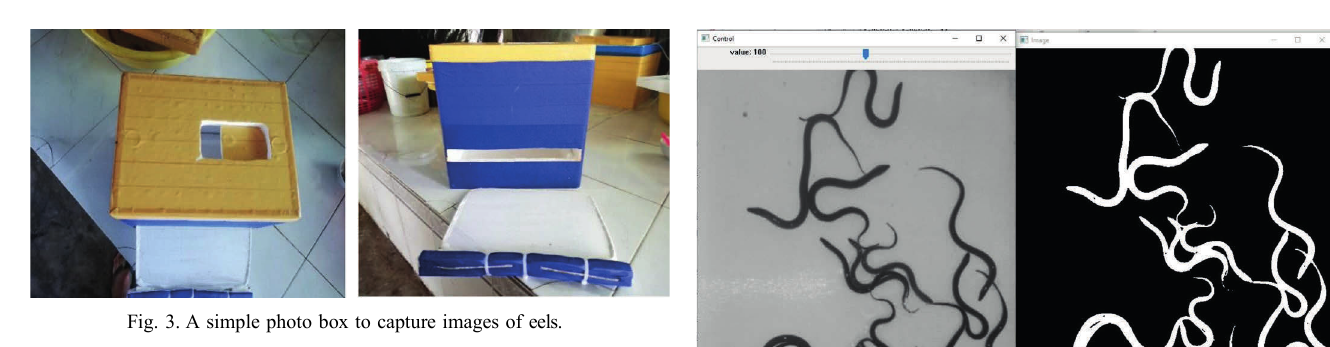
Fig. 2. The proposed workflow for counting eels.